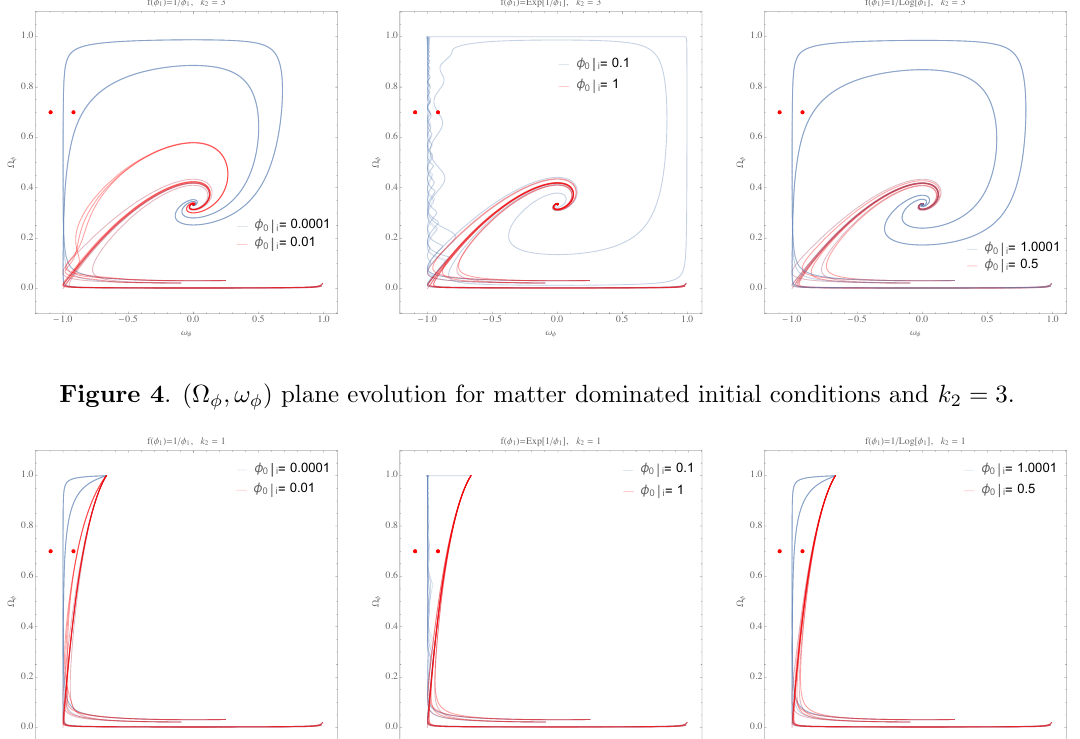
Figure 5 . ((cid:10) (cid:30) ; ! (cid:30) ) plane evolution for matter dominated initial conditions and k